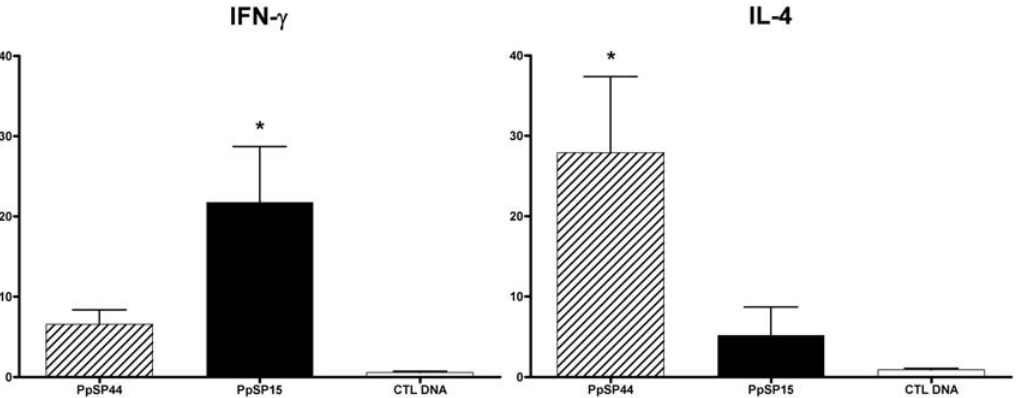
Figure 6. Sand fly bites efficiently recall the immune response in mice immunized with PpSP15 or PpSP44. Two hours after challenge with sand fly bites, expression of IFN- c and IL-4 was compared in mice immunized with CTL DNA, PpSP15 or PpSP44. Relative mRNA expression was determined by real time PCR and normalized to the18S housekeeping gene. Values represent the fold increase over naı¨ve mice after sand fly bites. Bars represent the mean 6 the SEM for 16 mice per group. Asterisks indicate significance ( p ,